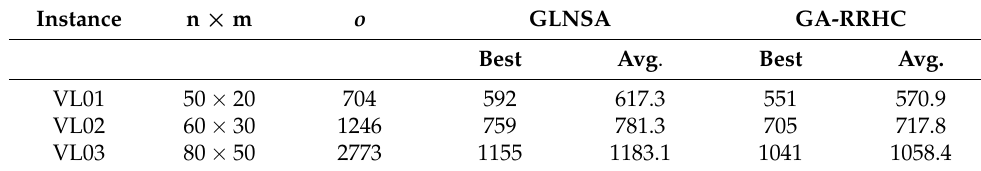
Table 11. Experiment with large instances.